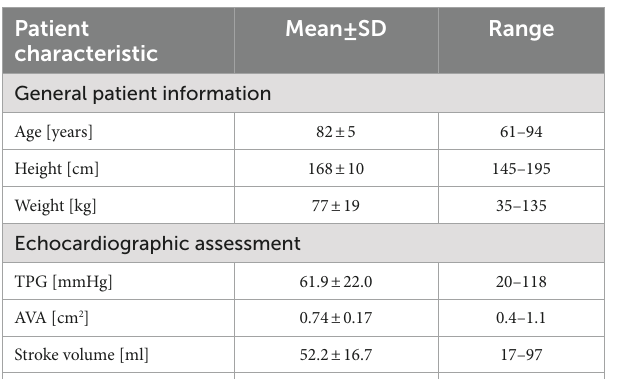
TABLE 1 Patient characteristics.